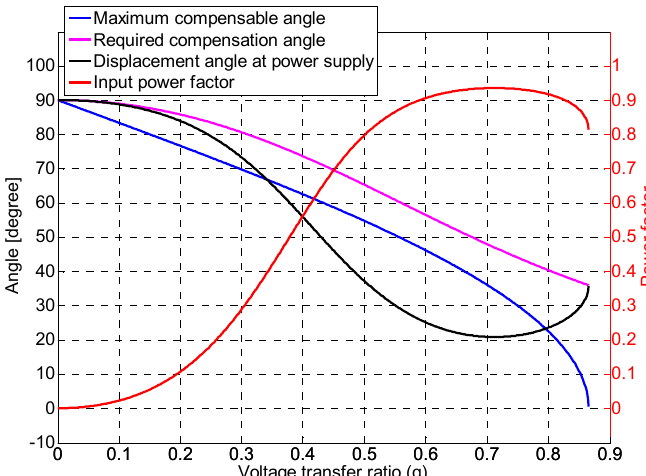
Figure 10. Maximum allowable compensated angle, required compensation angle, displacement angle, and IPF at the main power supple at Q = 0.54.